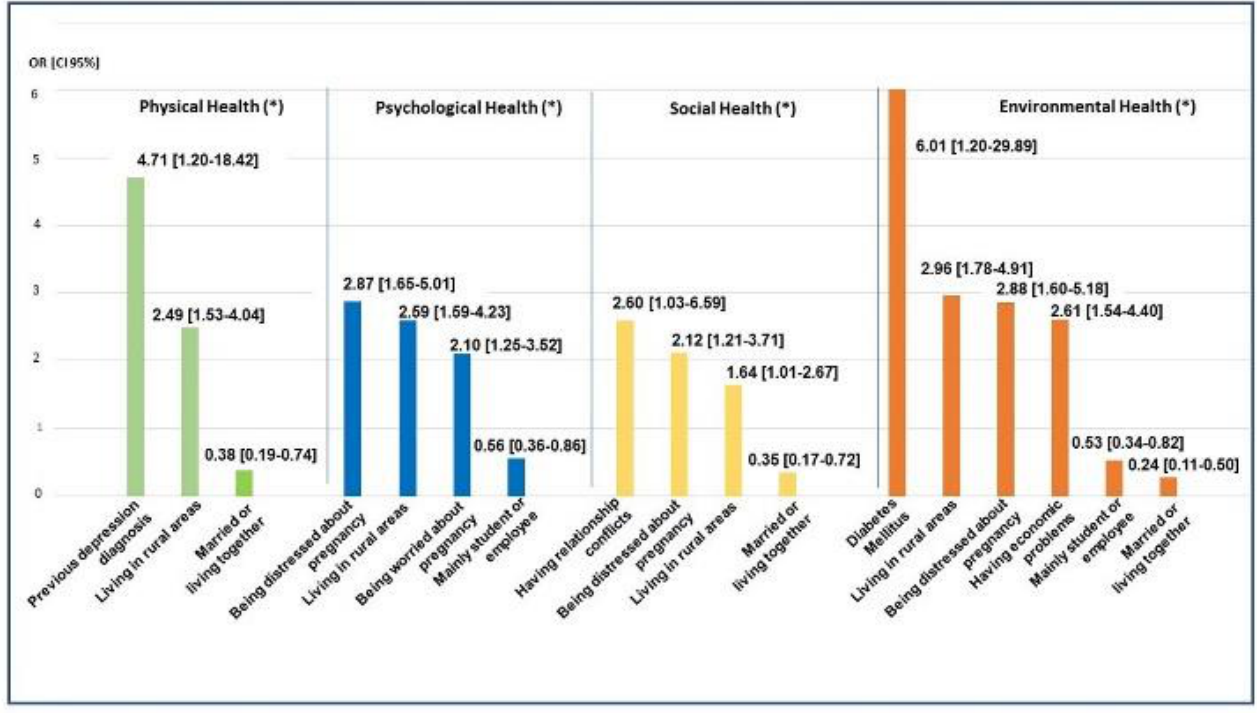
Figure 1: Factors associated with impairment of the physical, psychological, social and environmental domain of quality of life explored by the WHOQOL-BREF Scale. Adjusted logistic regression (*) p<0.05. Variables included in the adjusted logistic regression: age range, parity, main activity, marital status, area of residence, religiosity, being distressed or worried about pregnancy, having economic or couple problems, gestational nutritional status, pregnancy trimester, chronic arterial hypertension, asthma, sickle cell anaemia, hypothyroidism, gestational diabetes, gestational anemia, urinary tract infection in